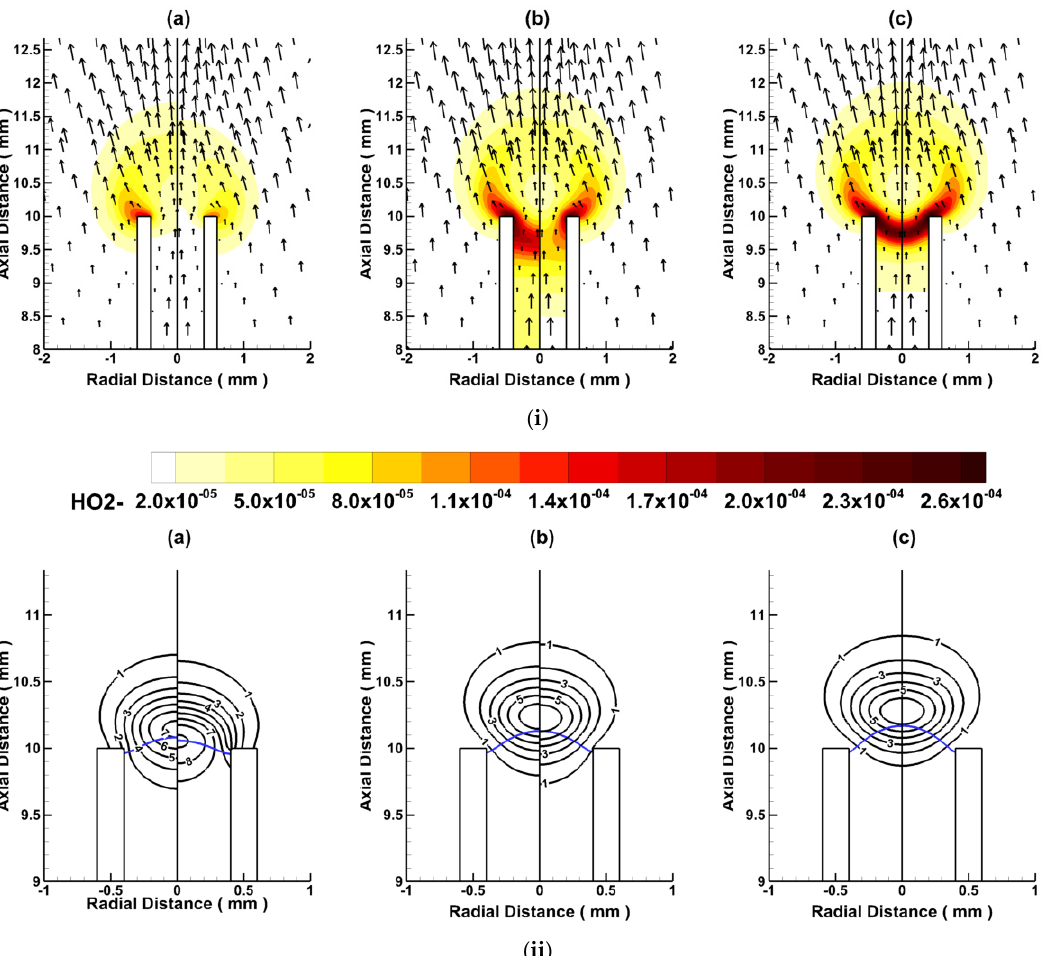
Figure 8. ( i ) Contours of HO 2 mass fraction along with velocity vectors. ( ii ) Mass fraction of H and stoichiometric mixture fraction, ( a ) quartz v = 0.13 m/s, ( b ) steel, v = 0.14 m/s and ( c ) aluminum, v = 0.14 m/s; left side—with radiation effects; right side—without radiation effects.